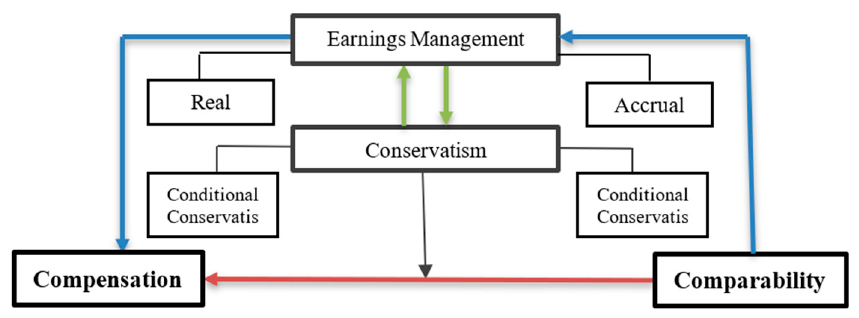
Figure 1. Earnings management and accounting conservatism